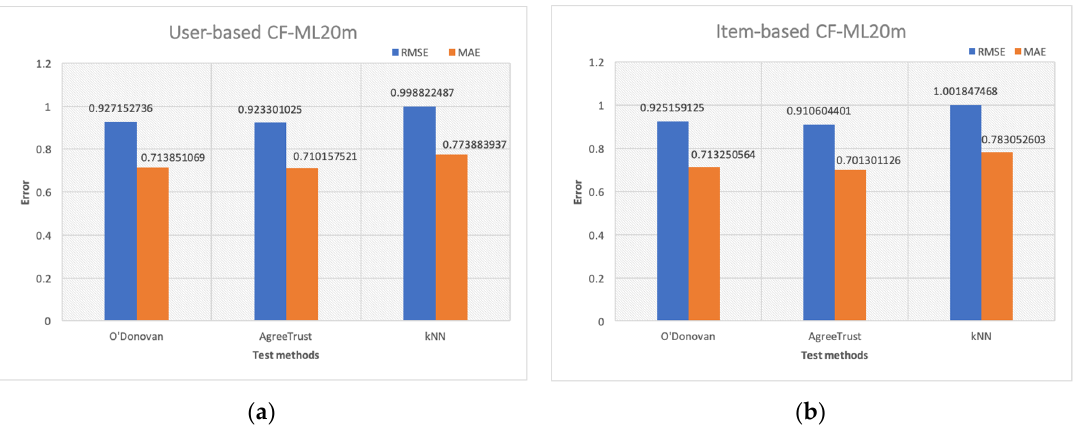
Figure 1. Result of three collaborative filtering (CF) methods for the ML-20m dataset: ( a ) user-based and ( b ) item-based. RMSE—root mean square error; MAE—mean absolute error; kNN—k-nearest neighbor.